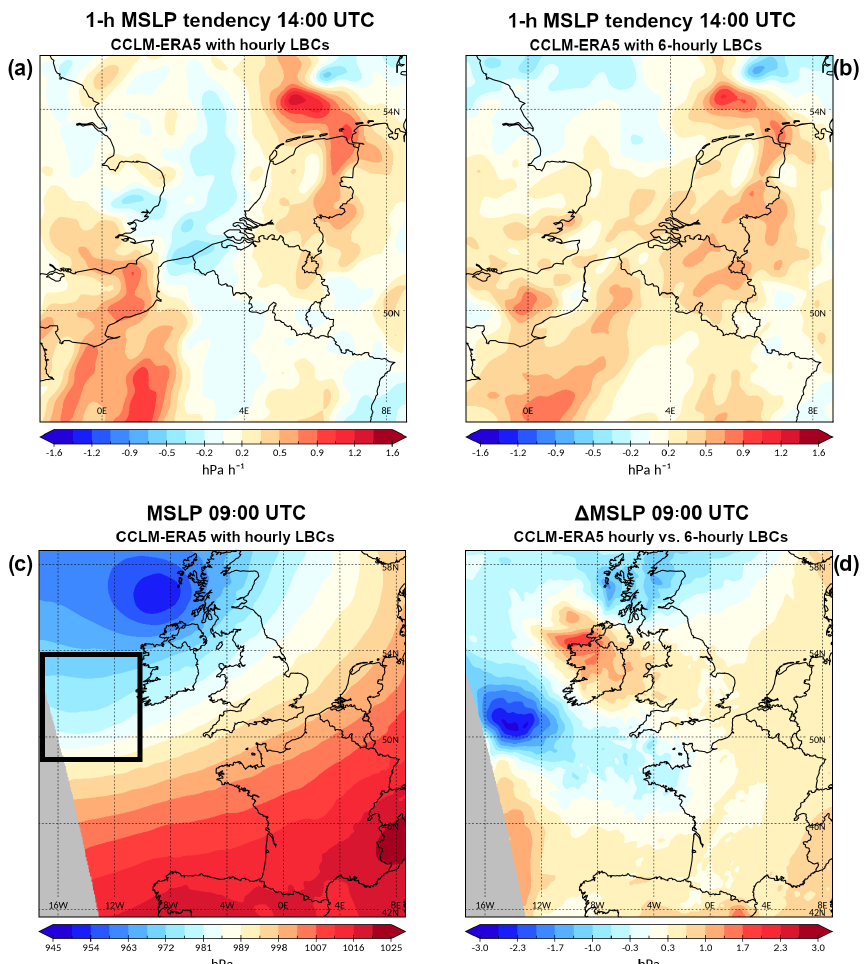
Figure 9. Results from CCLM-ERA5 7km simulation with (a, c) hourly and (b) 6-hourly lateral boundary conditions (LBCs). (a, b) 1- hourly mean sea level pressure (MSLP) tendency (hPah − 1 ; shaded) at 14:00UTC, (c) MSLP (hPa; shaded) at 09:00UTC and (d) MSLP difference (hPa; shaded) at 09:00UTC between simulations with hourly and 6-hourly LBCs. The black outlined box in (c) highlights the surface pressure trough, which entered the computational domain from the